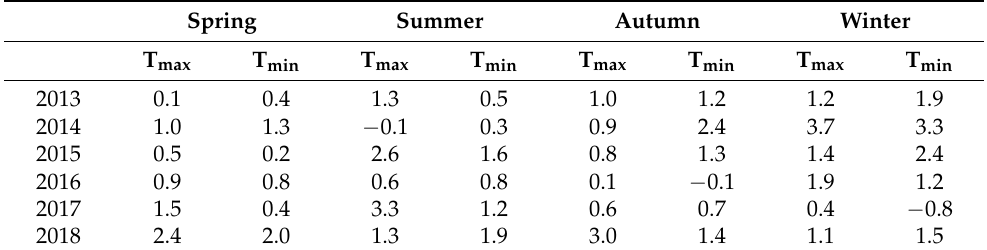
Table 2. The average seasonal anomaly of T max and T min for four selected climatological stations in respect to mean T max and T min for the 1981–2010 period (station Vrsac is not included since data were not available for this entire climatological period).